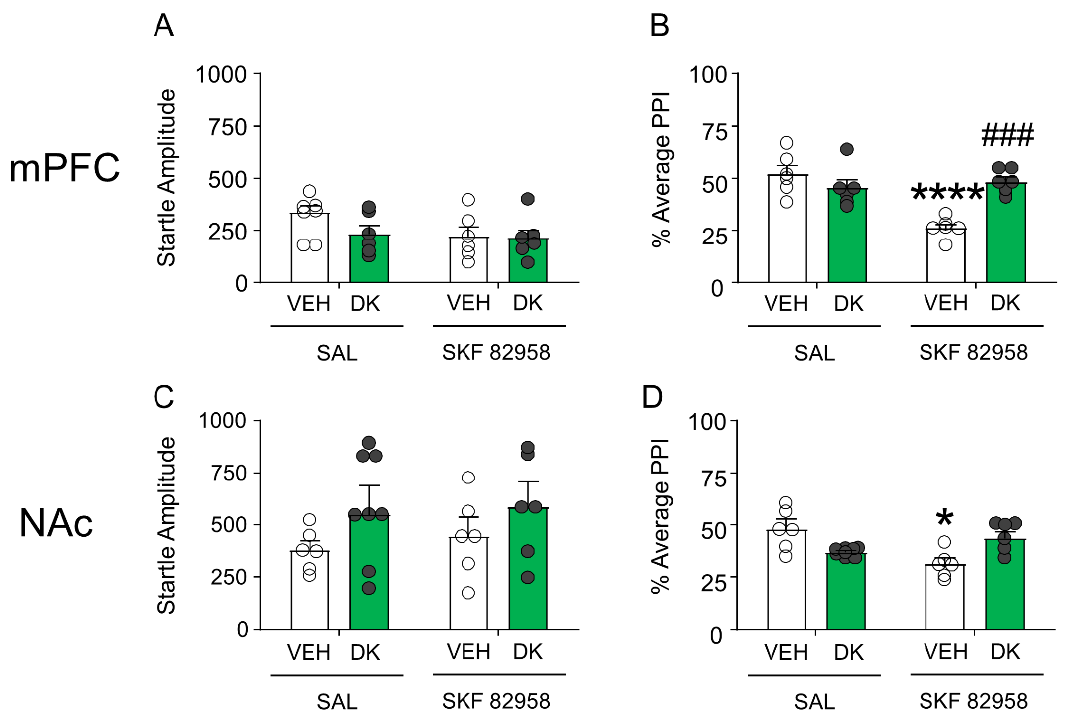
Figure 9. DK-I-56-1 (DK, 10 nmol) infusion in the medial prefrontal cortex (mPFC) ( A ) failed to affect startle reflex in mice, but ( B ) significantly countered the PPI deficits produced by SKF 82958 (F(1,20) = 19.34; p = 0.0003). Conversely, infusions of this drug in the nucleus accumbens (NAc) ( C ) did not affect startle amplitude, and ( D ) failed to reverse the PPI deficits induced by SKF 82958. All analyses were performed by 2-way ANOVAs. Significance levels refer to the results of post-hoc comparisons. * p < 0.05; **** p < 0.0001 vs. mice treated with the vehicle of DK (VEH) and saline (SAL, controlling for SKF 82958); ### p = 0.0001 vs. mice treated with VEH and SKF 82958. n = 6–8/group. For further details, see text.